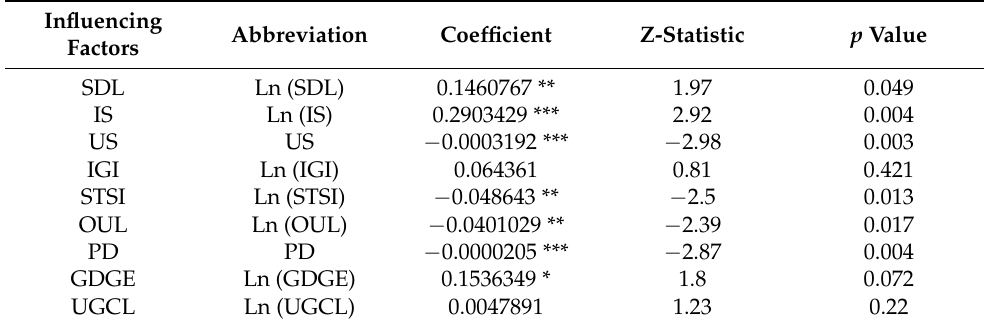
Table 8. Tobit model regression